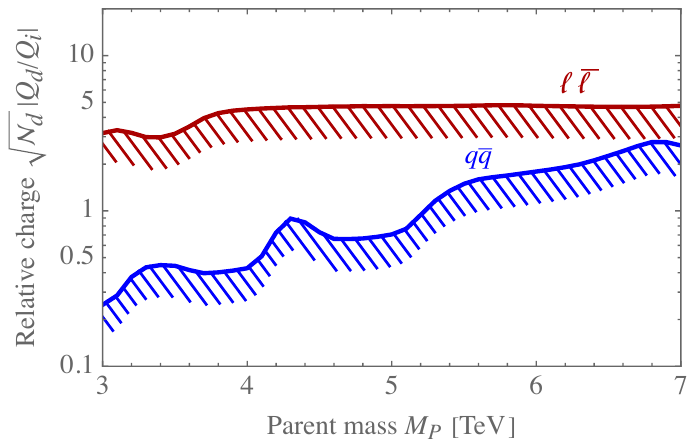
√ N d | Q d /Q q | (for the